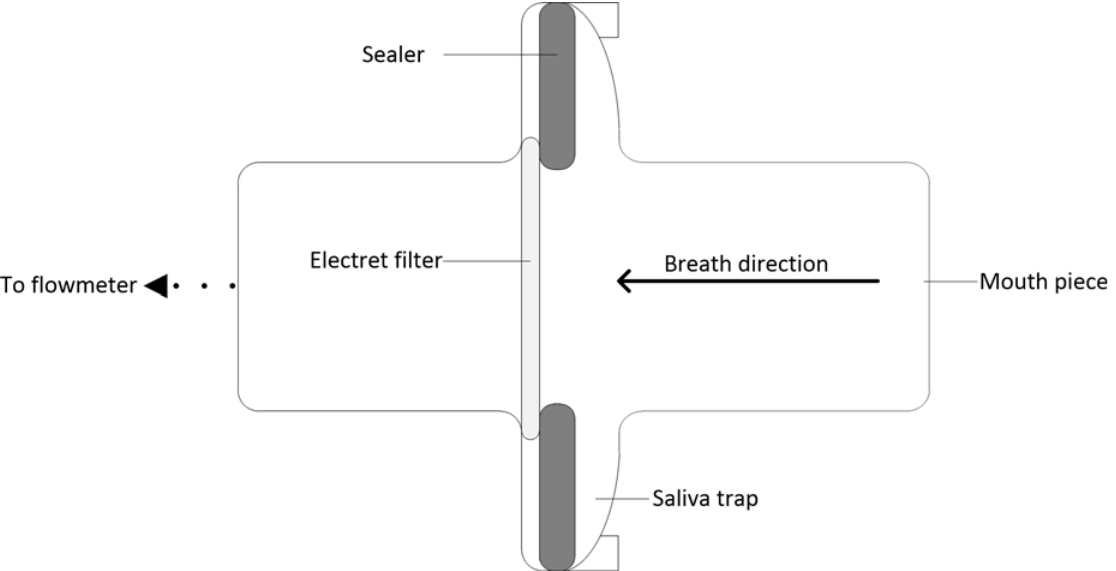
Fig 2. Schematic diagram of the designed collecting device in vertical